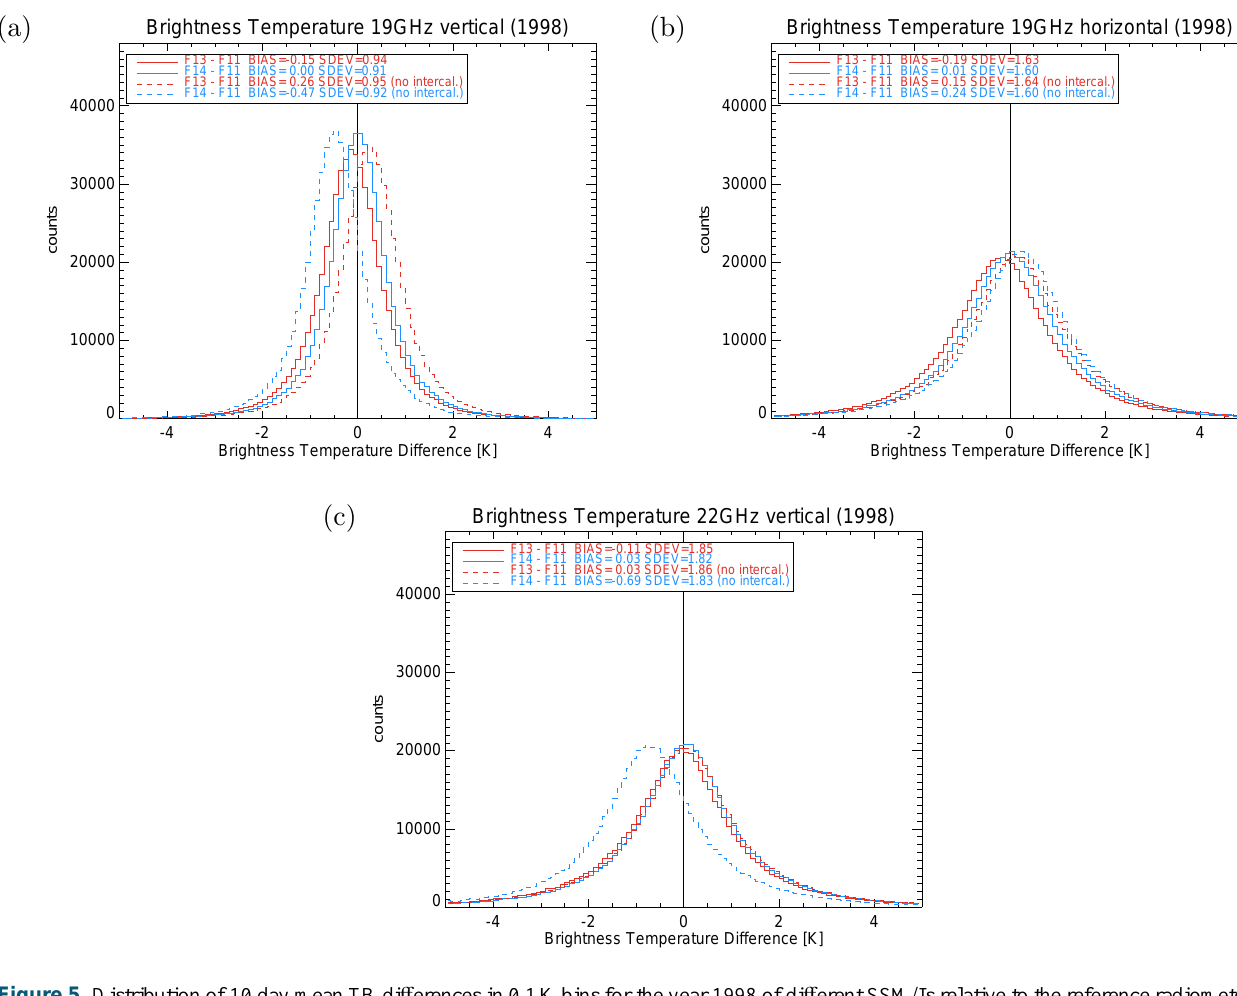
Figure 5. Distribution of 10 day mean TB di ff erences in 0.1K bins for the year 1998 of di ff erent SSM / Is relative to the reference radiometer on DMSP F11. The panels show the comparisons without (dashed lines) and with (solid lines) intercalibration for TB 19v (a) , TB 19h (b) , and TB 22v (c)